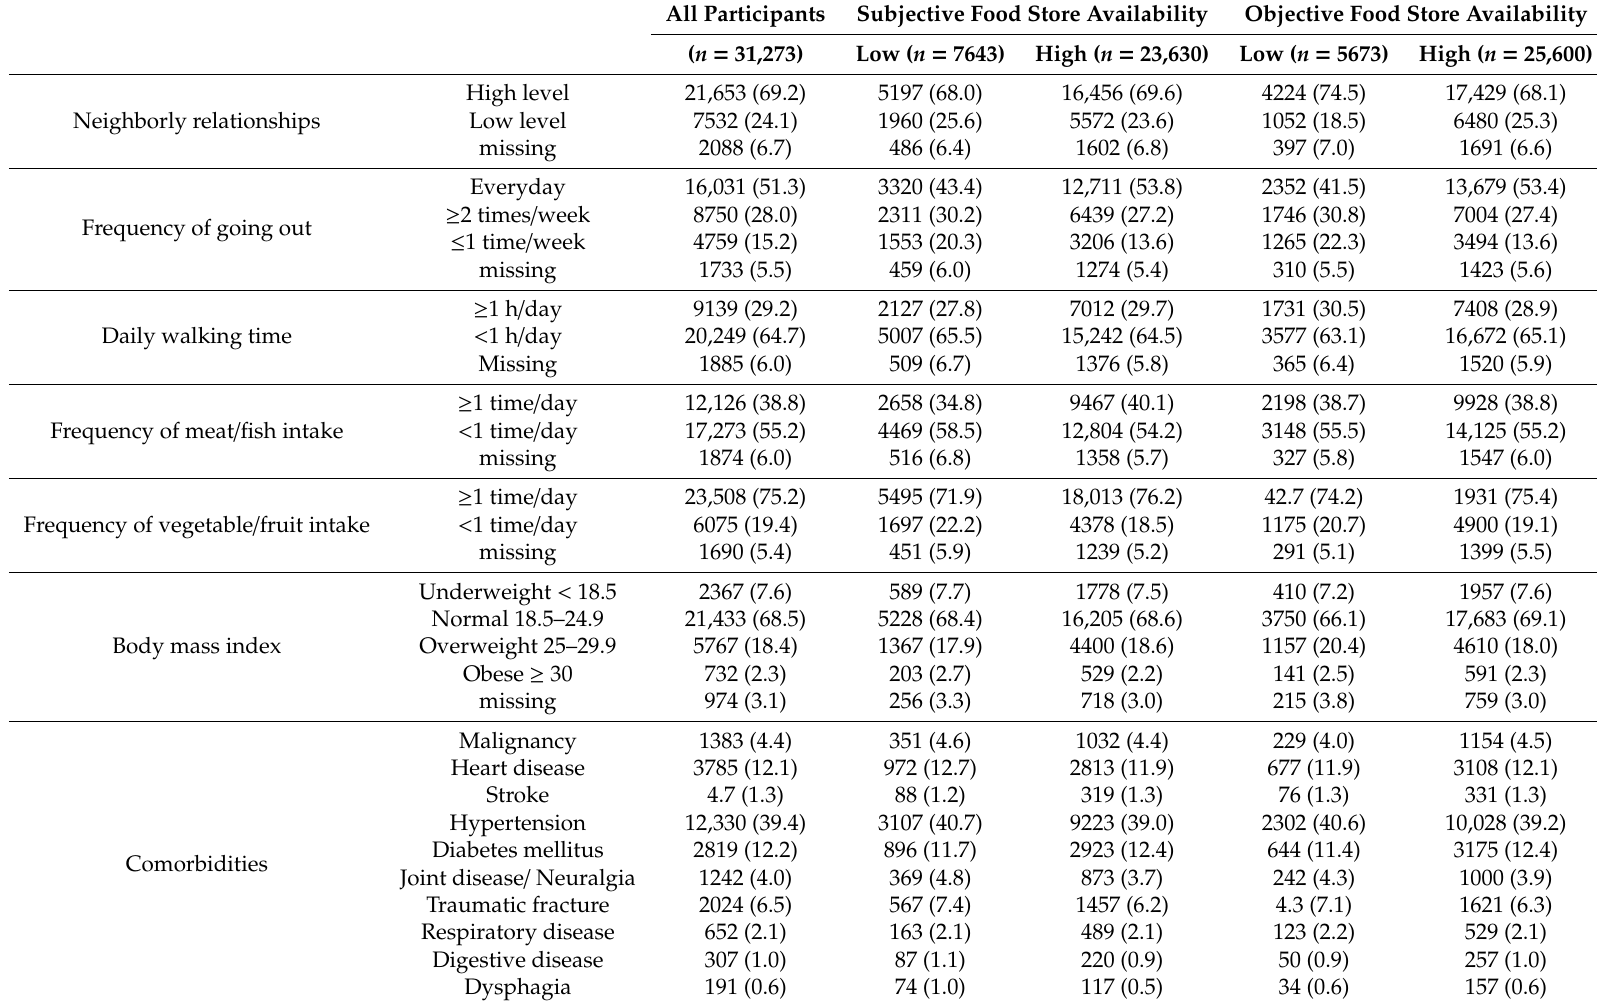
Table 2. Baseline characteristics of participants and incidence of functional disability after 6